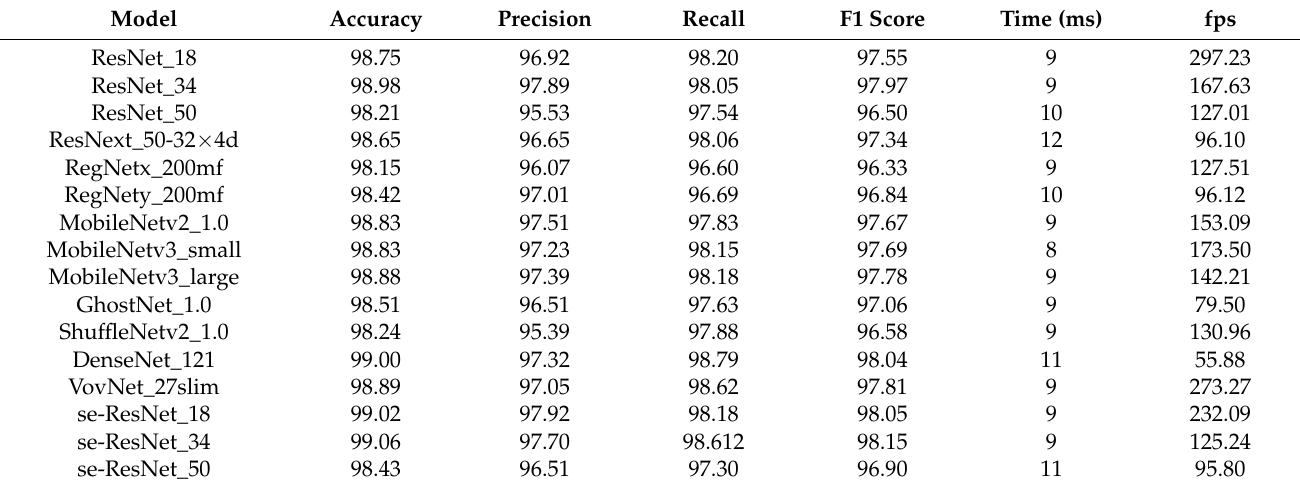
Table 4. Comparison of classification networks (input size is 4096 pixels (64 × 64)).